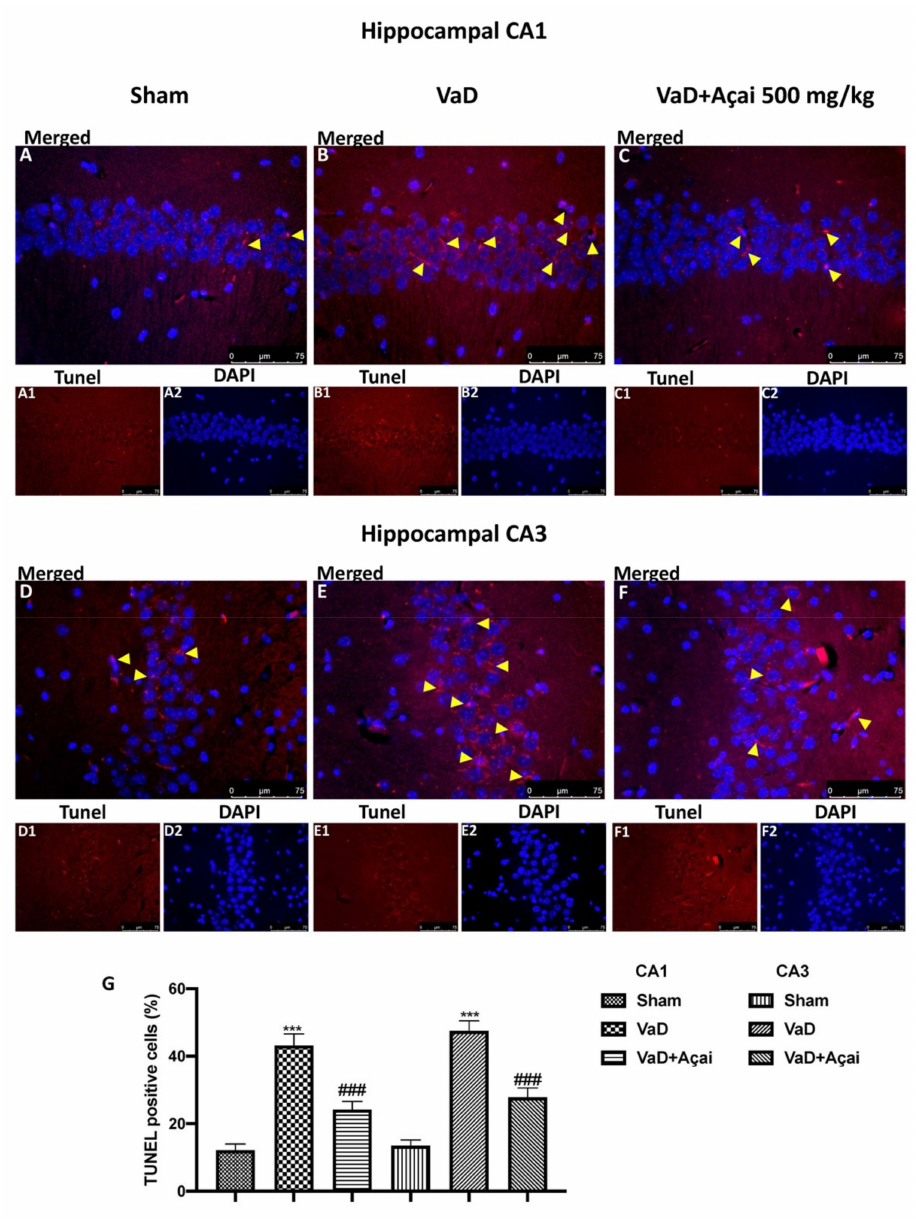
Figure 4. Açai berry reduces hippocampal TUNEL positive staining. Hippocampal CA1 figure of Sham ( A , A1 , A2 ), VaD ( B , B1 , B2 ), Açai Berry ( C , C1 , C2 ); Hippocampal CA3 figure of Sham ( D , D1 , D2 ), VaD ( E , E1 , E2 ), Açai Berry ( F , F1 , F2 ); count of dead cells ( G ). Arrows indicate TUNEL positive cells, merged with DAPI. Figures are representative from at least three experiments. Values are means ± SEM of six mice for all groups. See manuscript for further details. *** p < 0.001 vs. sham; ### p < 0.001 vs.